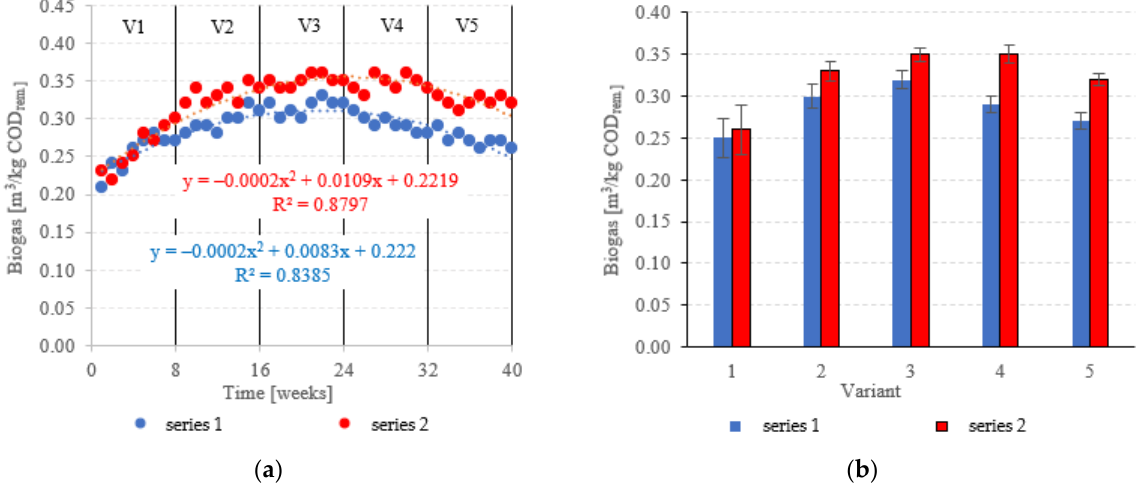
Figure 15. specific biogas production (( a ) changes throughout the experiment; ( b ) average specific across experimental variants).